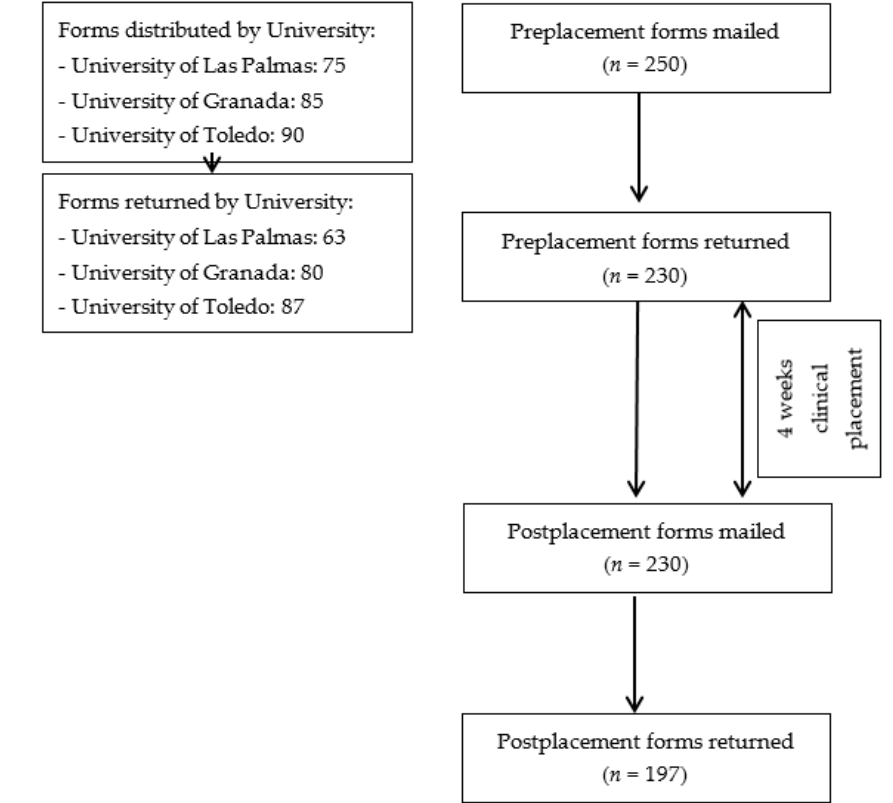
Figure 1. Distribution and returning of questionnaires.